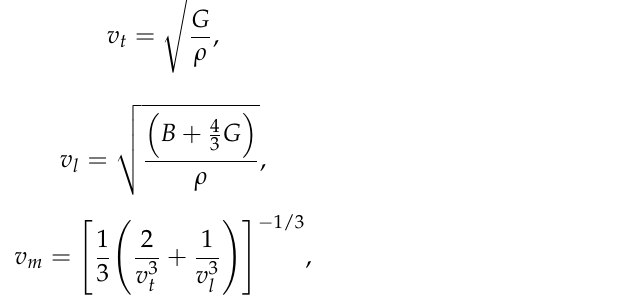
Table 4. Calculated thermodynamic parameters: Debye temperatures (K), and minimum thermal conductivities ( k , W/(m · K)) of the AlNi 2 Ti intermetallic compound and Ni 3 Ti for comparison. Species Model Θ D